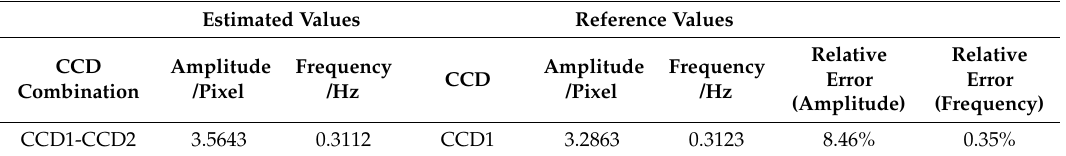
Table 8. The comparison of parameters of jitter displacement for HR images of